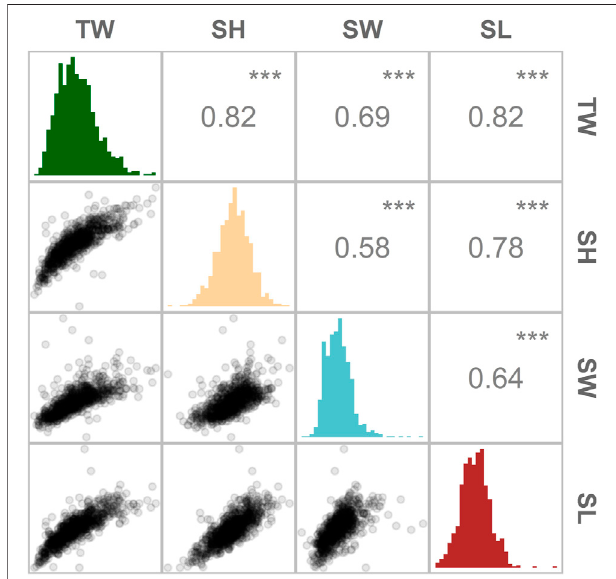
FIGURE 2 | Distribution and magnitude of the phenotypic correlations between growth-related traits in Ostrea edulis . Pearson ’ s correlationbetween traits (above the diagonal), histogram of trait distribution (diagonal) and scatterplotscomparingtwotraits(belowthediagonal).TW(totalweight), SL(shelllength), SH(shellheight)andSW(shellwidth).***indicatesp-values < 0.001.